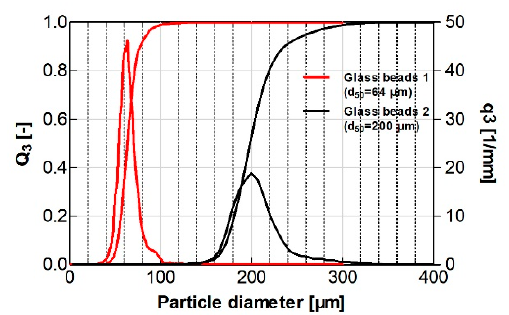
Figure 3. Initial normalized particle size distributions of the two groups of glass particles.